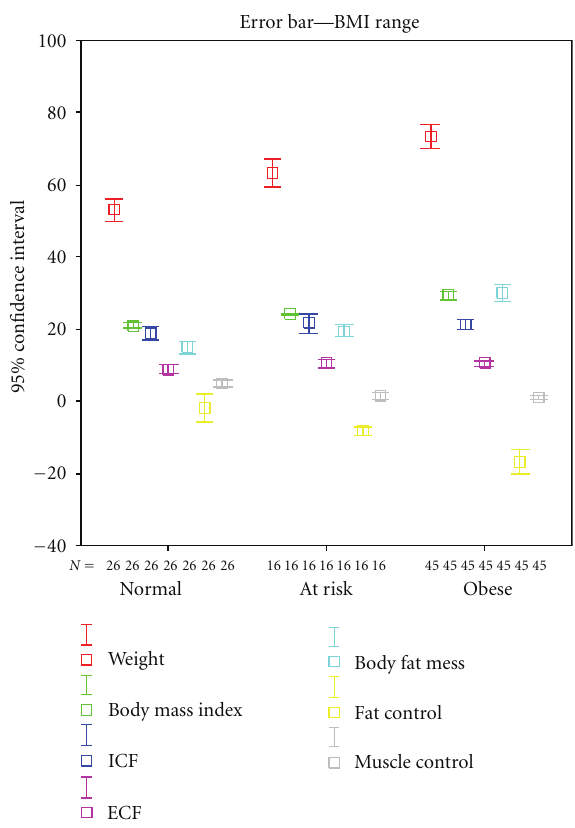
Figure 6: Error bar of BMI range with significance